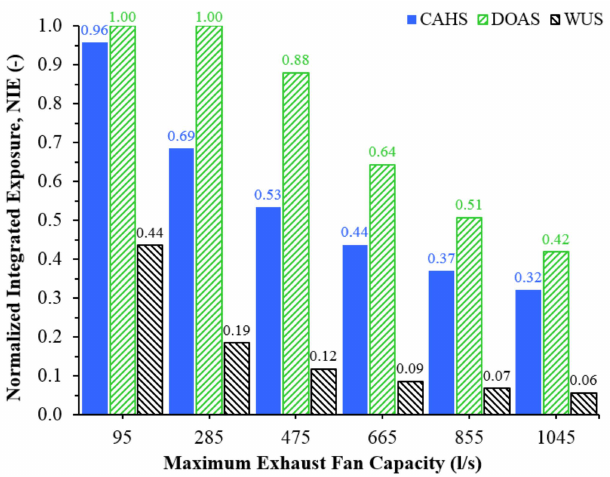
Figure 10. Effect of exhaust fan on the NIE of the three HVAC systems (CAHS, DOAS, and WUS) for 3 h. per day of continuous